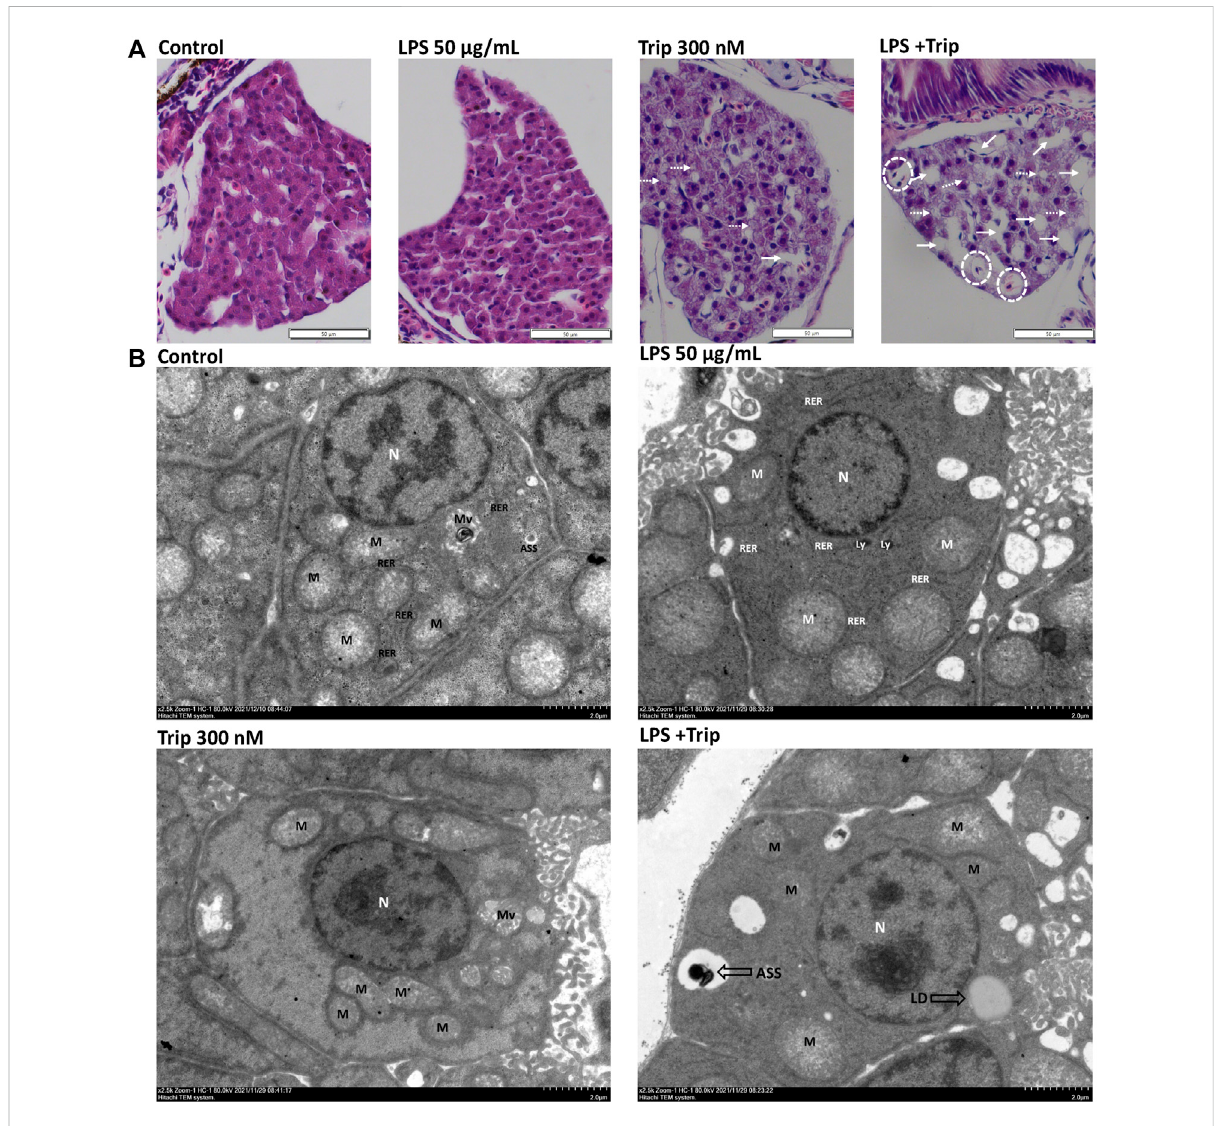
FIGURE 3 Theeffectoftriptolideonthelivertissuepathologyandhepatocyteultrastructureofzebra fi shinanin fl ammatorystate. (A) Hepaticpathological section staining, white dotted circles represent hepatocyte hypertrophy, white dotted arrows represent lipid droplets, and white arrows represent vacuolization. Magni fi cation ×40. (B) Electron microscopy of liver ultrastructure, nuclei (N), mitochondria (M), rough endoplasmic reticulum (RER), microvilli (Mv), lysosomes (Ly), autolysosomes (ASS), and lipid droplets